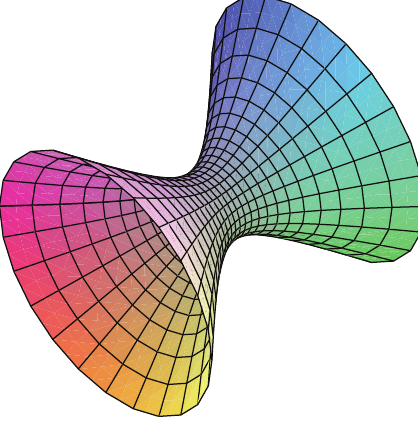
Figure 3: The de Sitter pseudosphere.